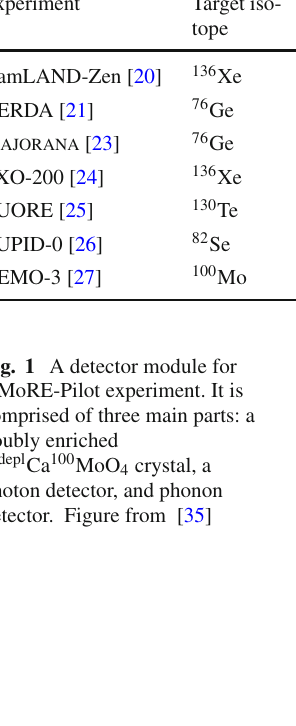
Table 1 A summary of the most sensitive 0 νββ decay search experi- ments. The target isotopes and the current half-life limits are shown Experiment